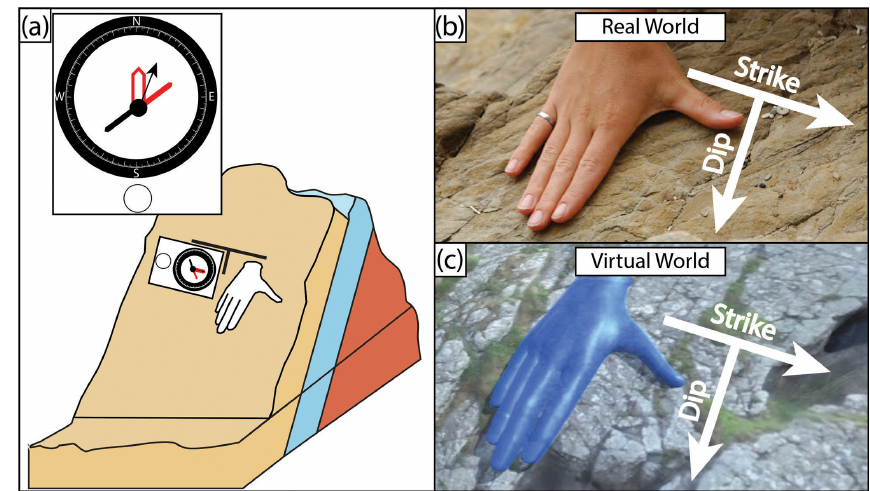
Figure 1. A schematic of how one measures strike and dip on an outcrop. (a) Strike and dip are measured on the planar surface of a rock. The strike represents the line at which the planar rock surface intersects with any horizontal plane. The dip angle is the angle between that dipping surface and the horizontal plane. Panels (b) and (c) give examples of RHR use in the real world and in the SaD virtual field environment,